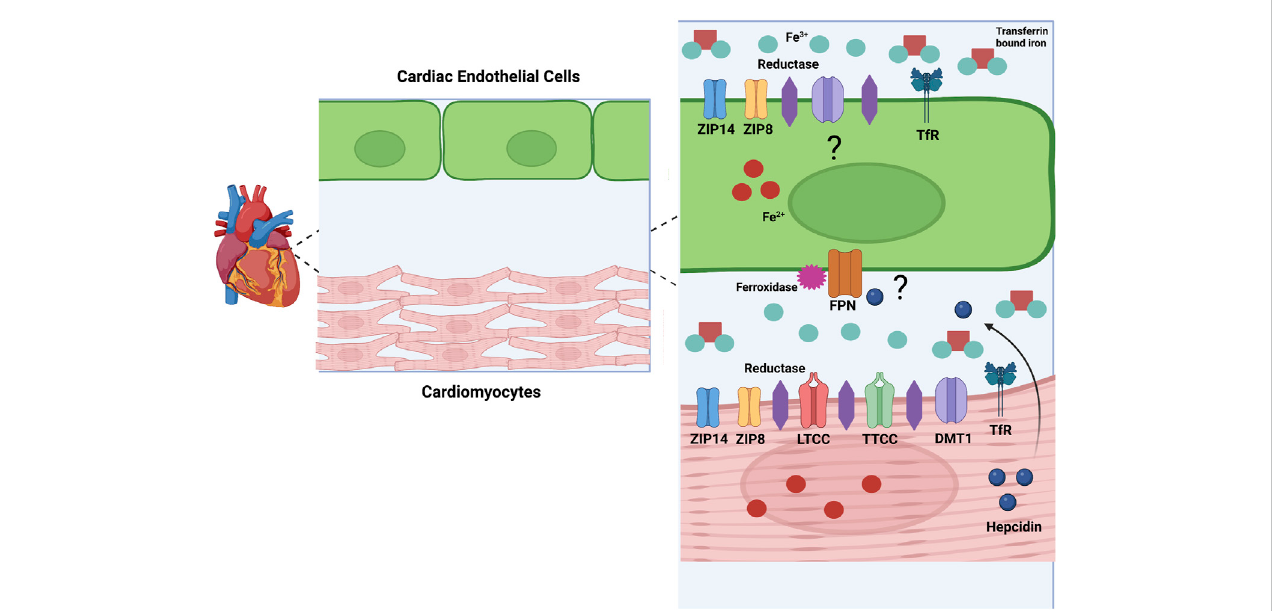
Model for Cardiac Iron Metabolism. This image represents a model of iron metabolism in cardiac tissue. Iron (Fe 2+ ) enters the heart through cardiac vascular EC. Mechanisms of iron uptake in cardiac EC are unknown, but I propose involvement of ZIP8, ZIP14, DMT1, and the Tf/TFR pathway. Speci fi cally, I propose that ZIP8 andZIP14can transport NTBIand TBI. Iron(Fe 2+ )leaves theEC throughFPN and isoxidized byaferroxidaseto Fe 3+ . Intheinterstitialspace, Fe 2+ isreducedbyacardiomyocyte reductaseand entersthecardiomyocyte through several possible transporters. ZIP14,ZIP8, LTCC, TTCC, DMT1,and the TfR pathway are all possible methods of iron uptake in cardiomyocytes. In conditions such as in fl ammation and hypoxia, hepcidin is produced in cardiomyocytes. As cardiomyocytes and EC are in paracrine contact, hepcidin could be released and alter FPN on the EC membrane, decreasing iron release from these cells. These are postulations, but more research needs to be done to con fi rm these methods of iron handling in cardiac cells. Created with